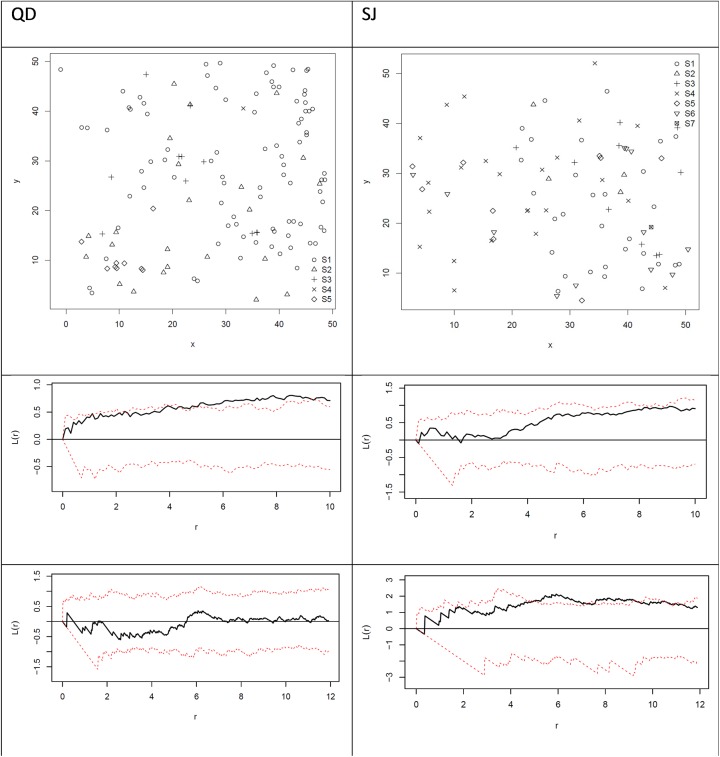
Sample plots (50 x 50 m) illustrating the location of each tree, univariate and bivariate L-functions.Sample plots (50 x 50 m) illustrating the location of each tree of diameter at breast height (DBH) above 7 cm in the very rare and species-rich Picea chihuahuana tree community in Quebrada de los Durán (QD) and San José de las Causas (SJ), Durango (Mexico). S1 represents the P. chihuahuana trees (above), and S2–S7 represent the other tree species. For the point patterns in the QDand SJ plots, univariate L-functions are represented by black lines. The 99% simulation envelope (dashed red lines) for the CSR hypothesis was calculated via the Monte Carlo Method (Besag 1977), with 1,000 simulations (central). For the point pattern in the QD and SJ plots, the bivariate L-function is indicated represented by black lines. The 99% simulation envelope (dashed red lines) for the Independence hypothesis was calculated by the Random Shifting Method (Lotwick & Silverman, 1983), with 1,000 simulations (below).